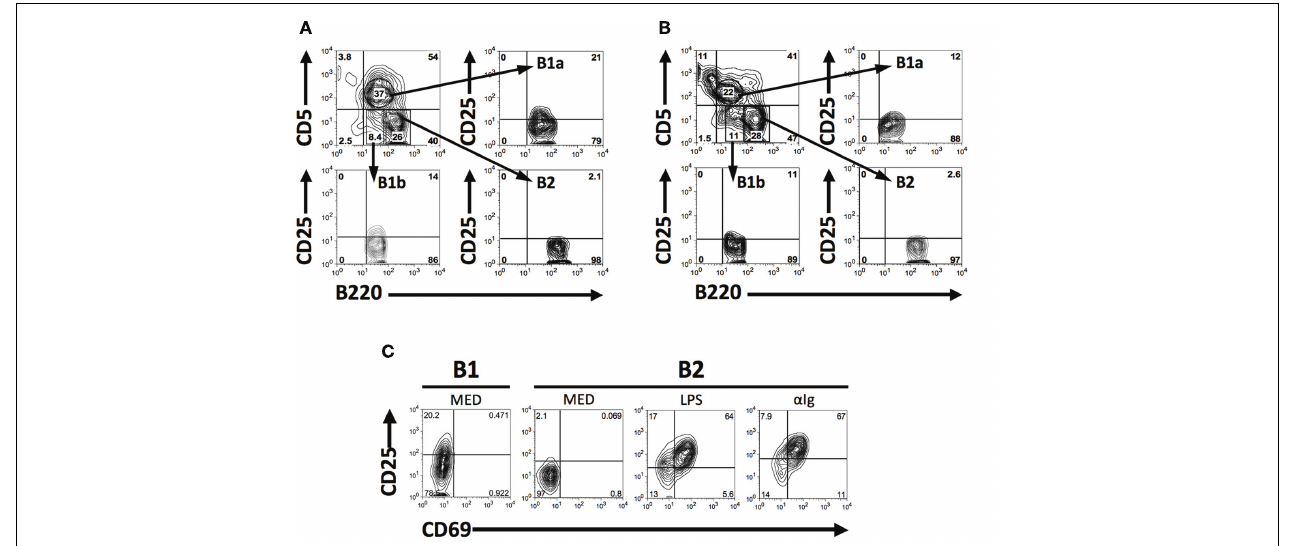
BALB/c B220 lo CD5 + B1a cells, and BALB/c splenic B220 + CD5 − B2 cells cultured in medium (MED) or stimulated with LPS (25 μ g/ml) or with F(ab (cid:2) ) 2 fragments of goat anti-mouse IgM (15 μ g/ml) for 2days, were immuno- fluorescently stained for CD25 and CD69. CD25 mean fluorescence intensity values (above background isotype staining) for CD25 + B1a cells and for CD25 + CD69 + B2 cells after stimulation with LPS and anti-Ig were, respect- ively, 53, 123, and 189. One of three comparable experiments is